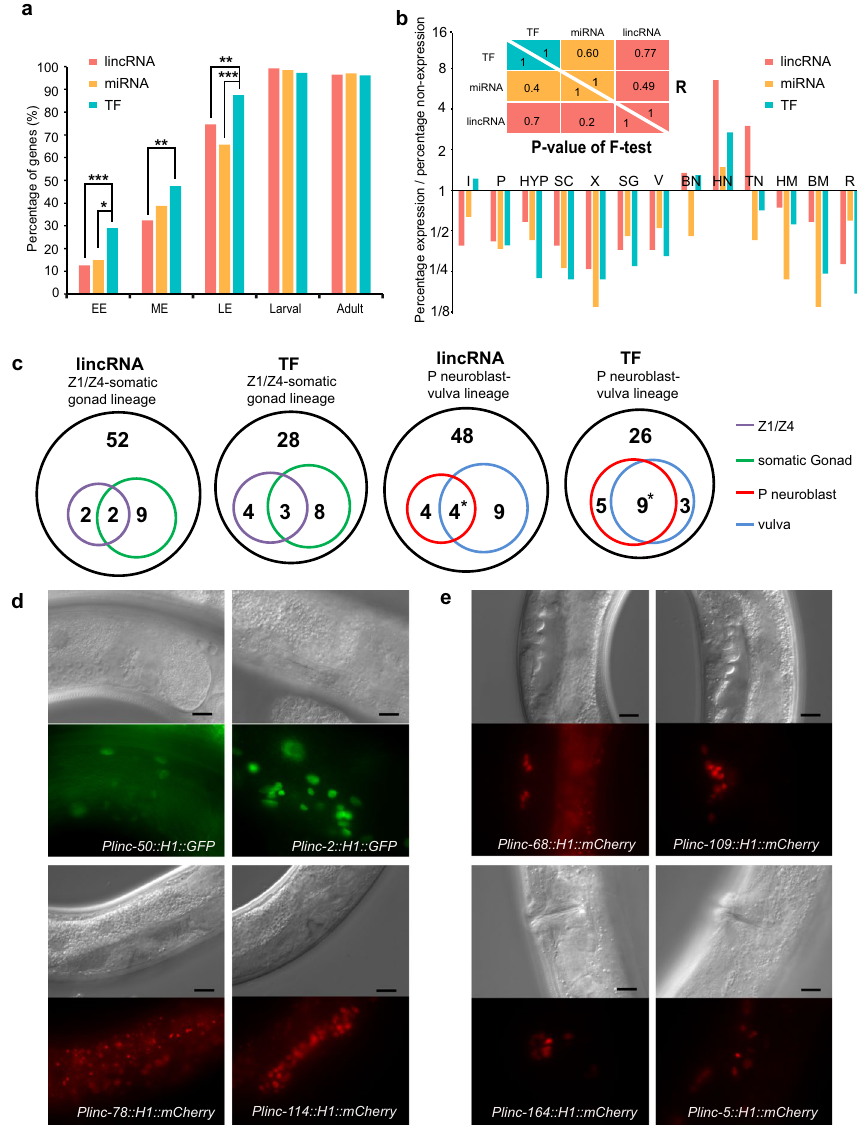
Figure 3. Comparison of spatiotemporal expression patterns of lincRNA, miRNA and TF reporters. ( a ) Temporal expression patterns of lincRNA, miRNA and TF reporters. Genes in each of the three categories whose promoter reporters show detectable activity are included in the comparison (lincRNA, 142; miRNA, 67; TF, 335). EE, early embryo (pre-comma stage); ME, middle embryo (comma to 1.5-fold stage); LE, late embryo (2-fold to 3-fold stage). * P < 0.05; ** P < 0.01; *** P < 0.001, Fisher’s exact test. Detailed information can be found in Supplementary Table S2. ( b ) Spatial expression patterns of lincRNA, miRNA and TF reporters. The percentage of each gene set expressed in a tissue is shown as an odds ratio. The upper right half of the triangle table shows the correlation of the probabilities of expressed genes in each somatic tissue between the three gene sets, in which Pearson correlation coefficients were calculated based on the log2(odds ratio); The lower left half of the triangle table shows the non-significant P-values resulting from a test of whether the variance of the probabilities that a gene is expressed in each of the somatic tissues is significantly different between each of the three gene sets, P-values were calculated based on the log2(odds ratio) using an F-test. I, intestine cells and intestinal muscle; P, pharynx; HYP, hypodermal cells; SC, seam cells; X, cells of excretory system; SG, somatic gonad; V, vulva and vulva muscle; BN, ventral nerve cord and body neurons; HN, head neurons; TN, tail neurons; HM, head muscle; BM, body muscle; R, anal depressor muscle, anal sphincter, rectal epithelium and rectal gland cell. Corresponding pictures can be found in the C.elegans lincRNA expression (CELE) database (wano.bioinfo.org). Detailed information can be found in Supplementary Table S4. ( c ) Number of lincRNA and TF reporters expressed in the Z1/Z4-somatic gonad lineage and the P neuroblast-vulva lineage. Black outer circle, the number of whole assayed lincRNA reporters and TF reporters. There is a significant overlap between genes expressed in P neuroblasts and in the vulva, P < 0.05, Fisher’s exact test. Detailed information can be found in Supplementary Table S4, S8. ( d , e ) Representative lincRNA reporters expressed in somatic gonad ( d ) and in vulva ( e ). Scale bar, 10 μ